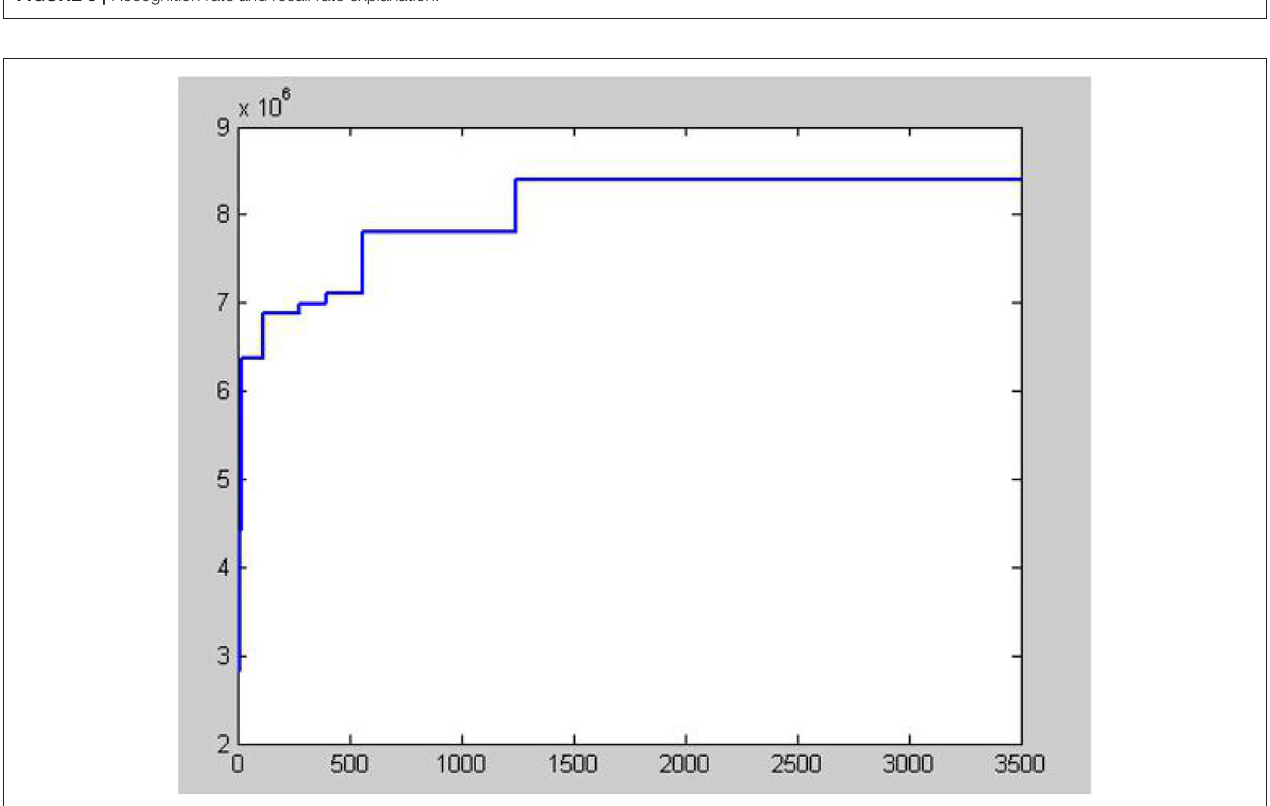
FIGURE 4 | Algorithm convergence